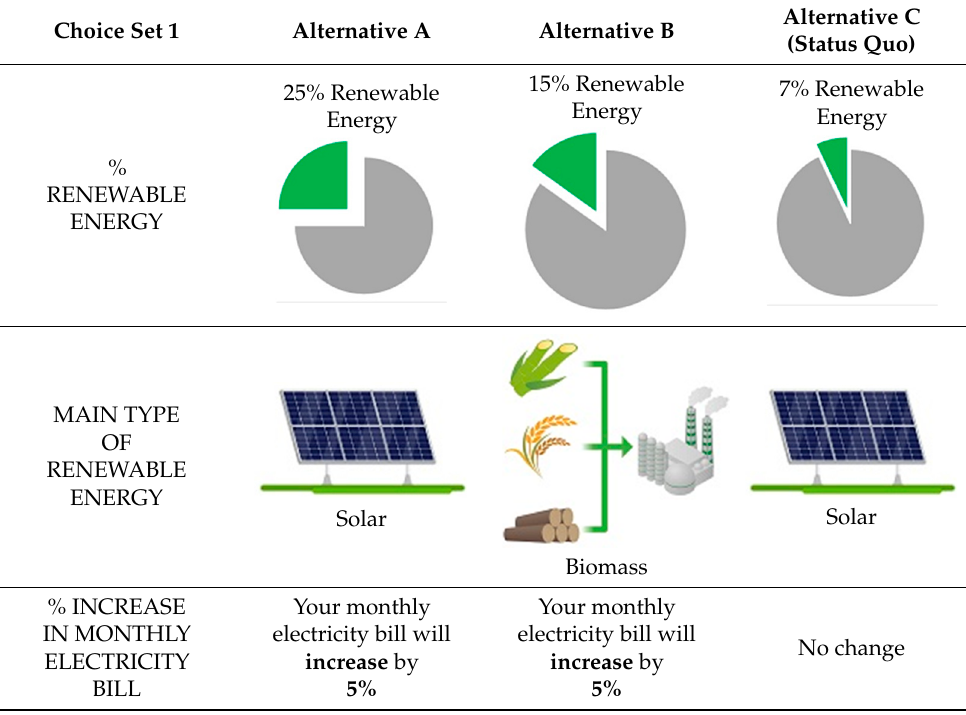
Table 1. Sample discrete choice experiment (DCE) survey question.